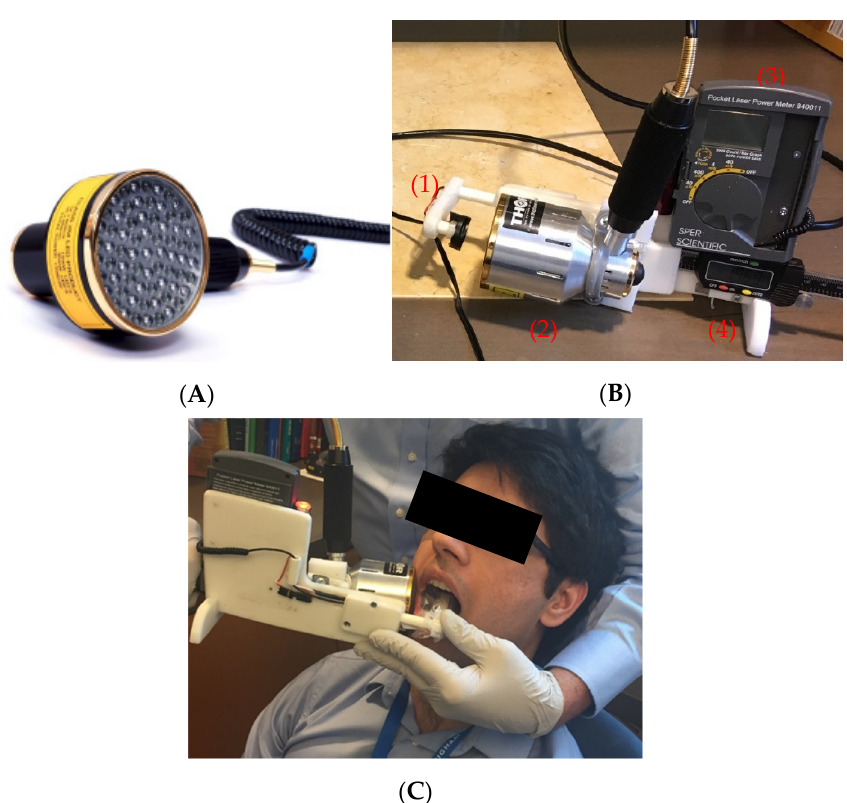
Figure 1. ( A ) LED probe provided by THOR Photomedicine Ltd. ( B ) Device used in validation study: (1) power meter sensor, (2) LED probe light source, (3) SPER Scientific Pocket Laser Power Meter, and (4) calliper for measuring cheek thickness. ( C ) The device used for in vivo transmission measurements. The LED probe was placed on the outside of the volunteer’s right cheek, with the light sensor placed on the surface of the mucosa,